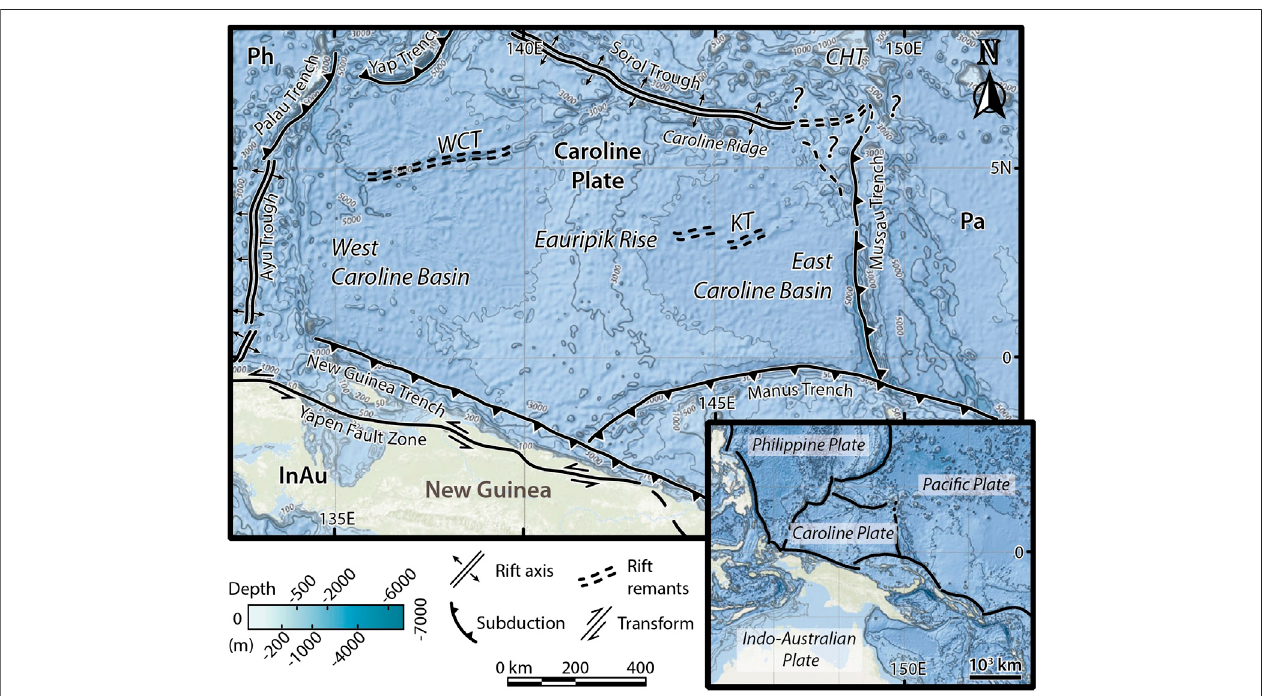
FIGURE1| TectonicsettingoftheCarolineplate.Thelower-rightinsetshowsthelargertectonicframeworkoftheCarolineplate.Themainpaneldepictsthenature ofthemaintectonicboundariesaroundtheCarolineplate(CooperandTaylor,1987;GainaandMuller,2007;Baldwinetal.,2012).Ph,Pa,andInAuaretheacronymsfor Philippine, Paci fi c, and Indo-Australian plates, respectively, the three major plates surrounding the Caroline Plate. WCT and KT are the West Caroline and Kiilsgaard troughs, remnants of a former spreading center. CHT stands for Caroline Hotspot Track. The bathymetric shaded-relief visualization of the GEBCO 2014 grid is shown as produced by NOAA/NCEI. Bathymetric depths and major morphologies are marked with equal-depth contours in kilometers.